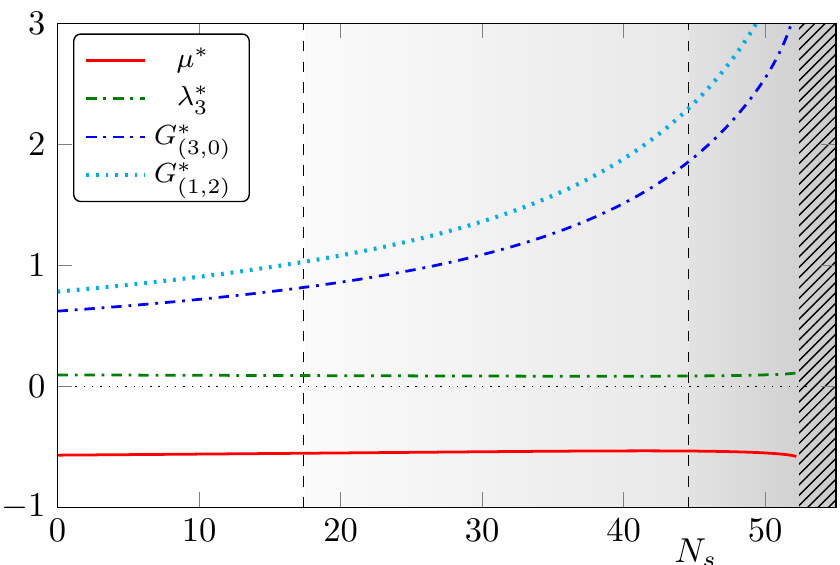
Figure 1: Fixed-point values for the fluctuation couplings as a function of N vertical lines at N